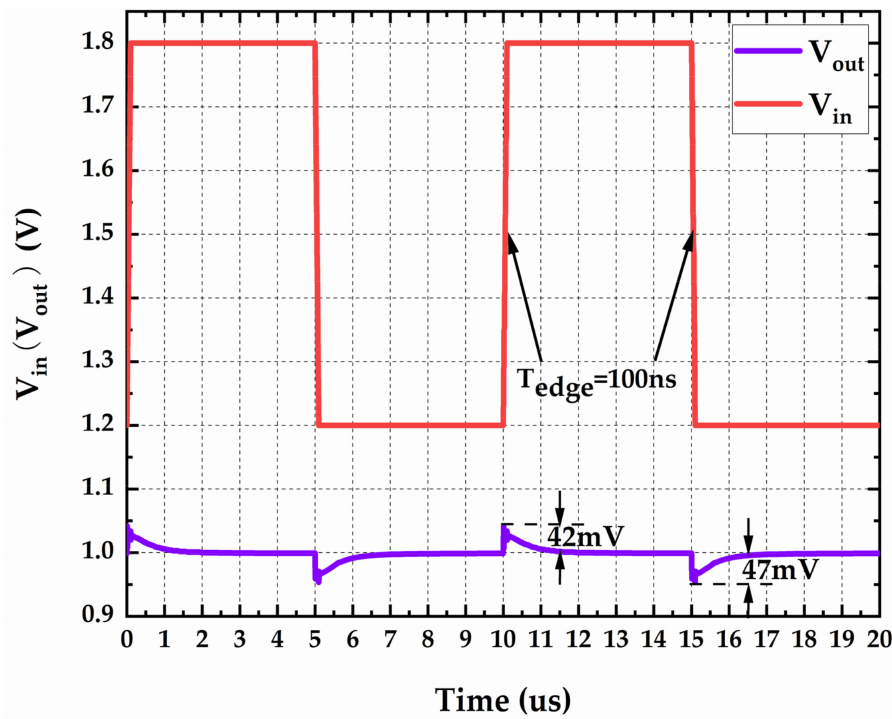
Figure 14. Simulated line transient response of the proposed